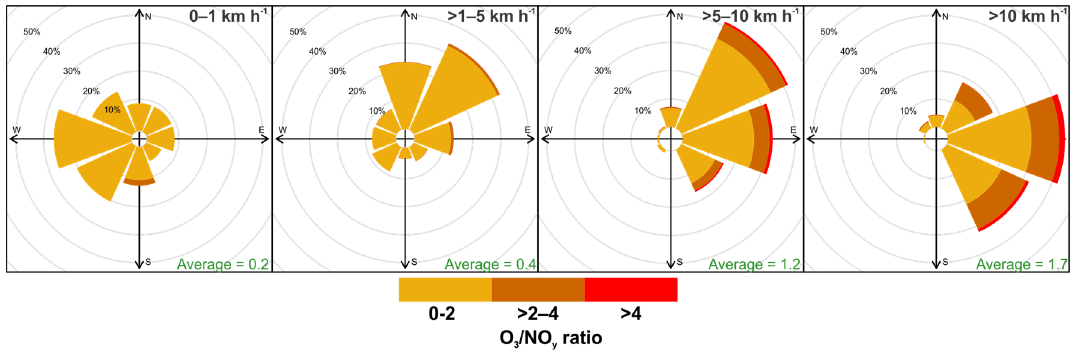
Figure 9. Pollution roses by WS of 1 h O 3 /NOy ratios calculated between 12:00 and 18:00 Central Daylight Time (CDT, GMT-0500) at the OBI site from September 2012 to August 2013.